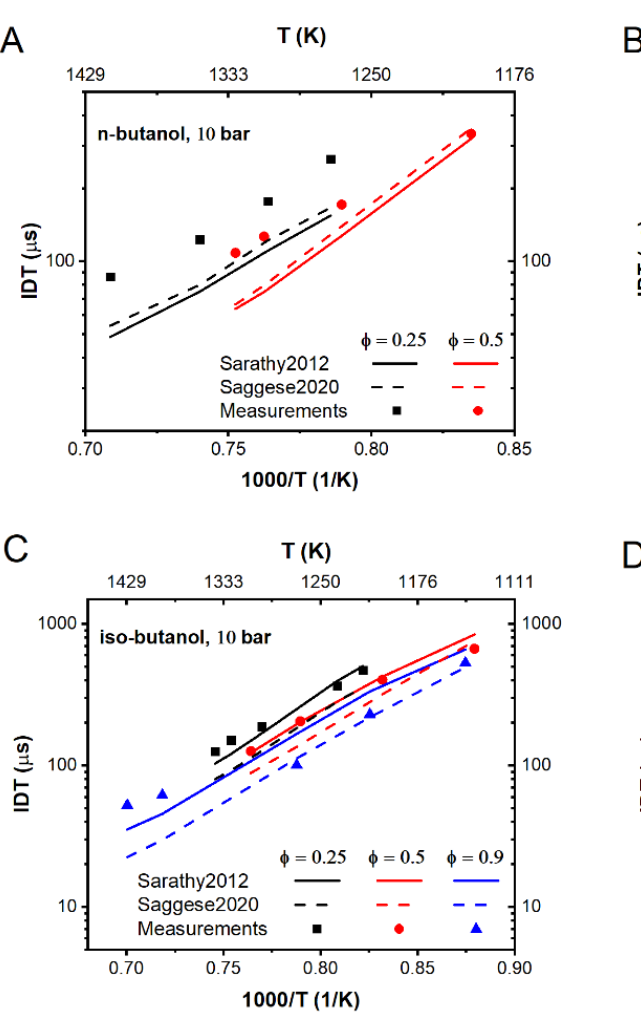
Figure 3. IDTs of ( A ) n-propanol, and ( B ) iso-propanol measured in the HPST at 10 bar and ϕ = 0.25, 0.5, and 0.9.